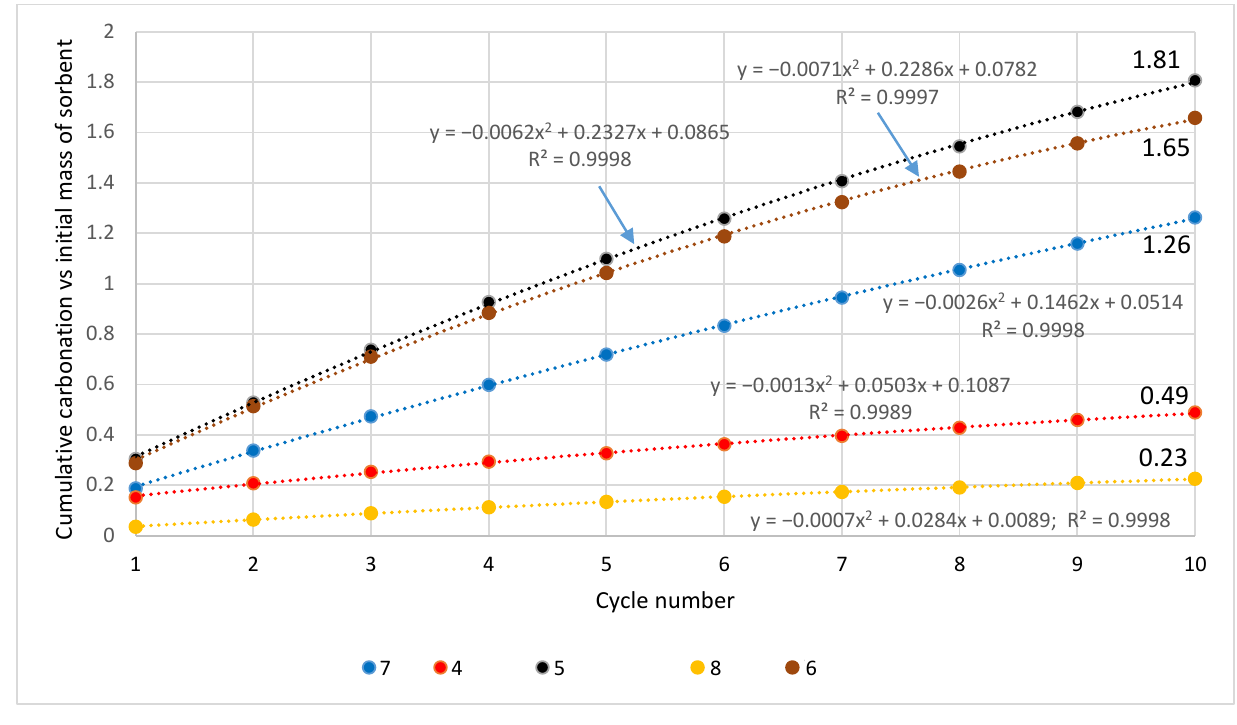
Figure 18. Cumulative carbonation relative to the initial mass of the sorbent—carbonate rocks.